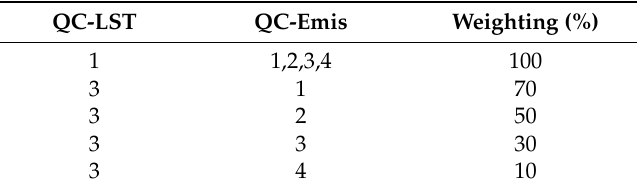
Table 3. Weighting of the meteorological stations according to the quality masks provided by the